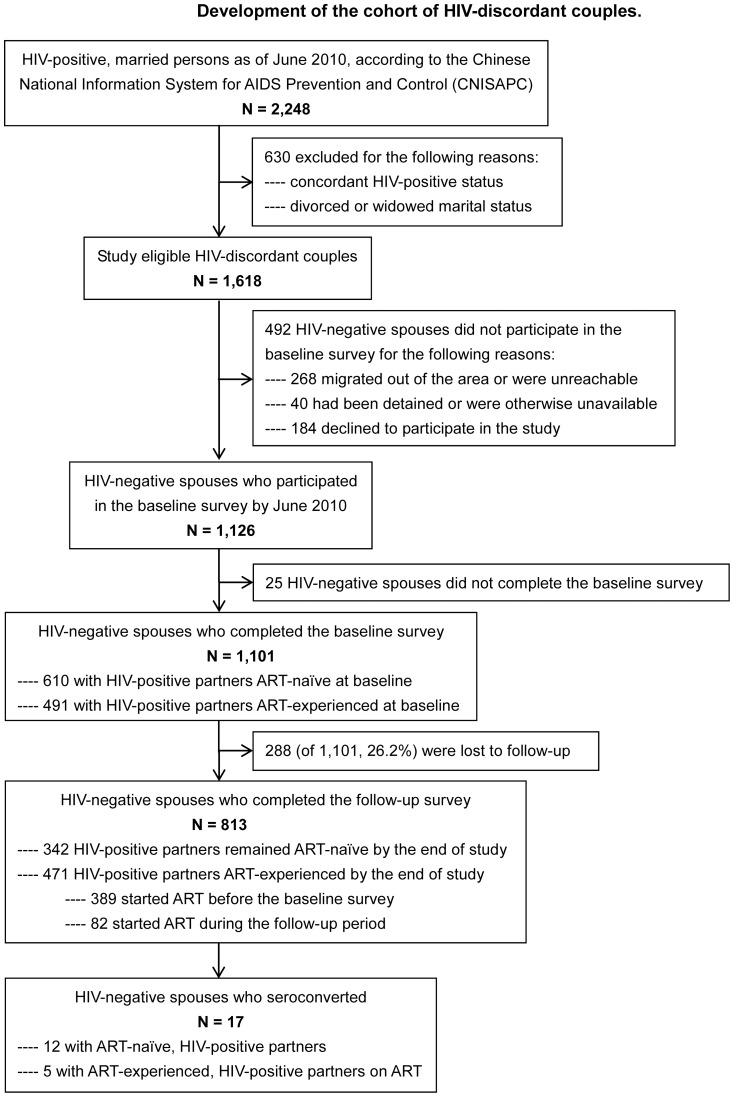
Flow chart depicting the development of the cohort of HIV-discordant couples who participated in this study of HIV discordant couples in rural Yunnan, China, 2009–2011.